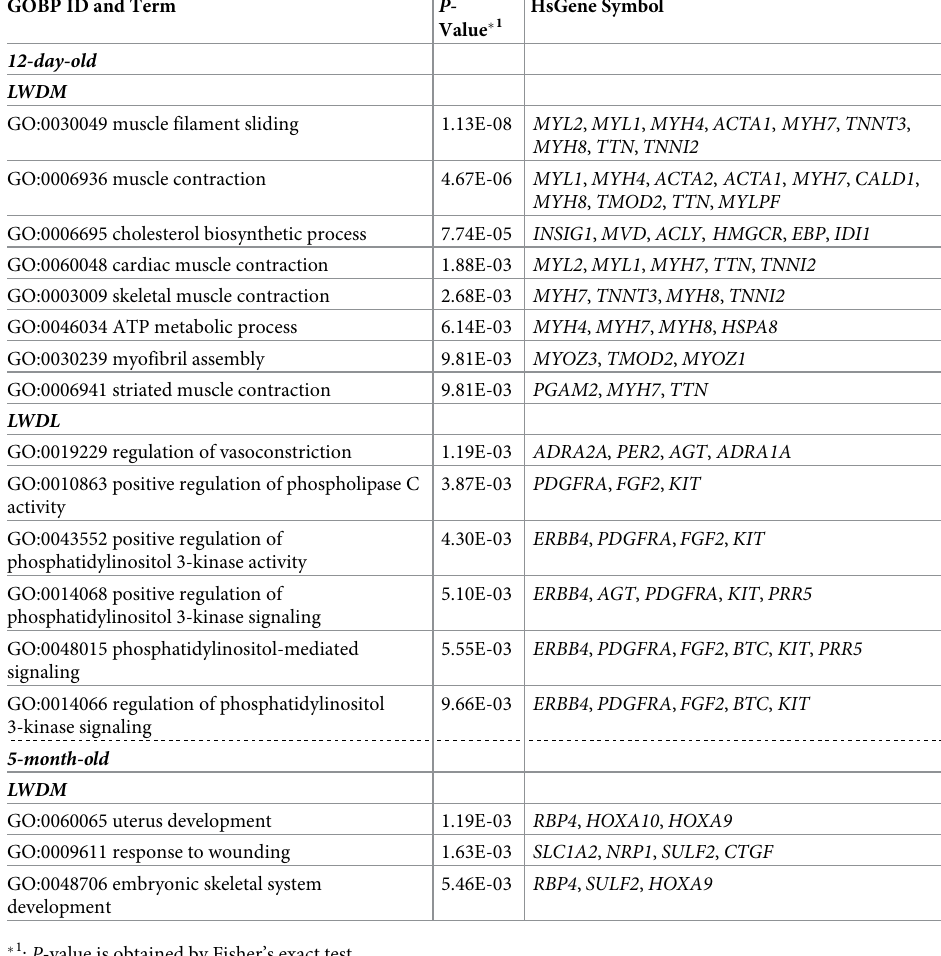
Table 3. Annotation profile of the genes with > 2.0-fold predominant expression in the subcutaneous adipose tis- sue (fat) of LWDM and LWDL pigs. GOBP ID and